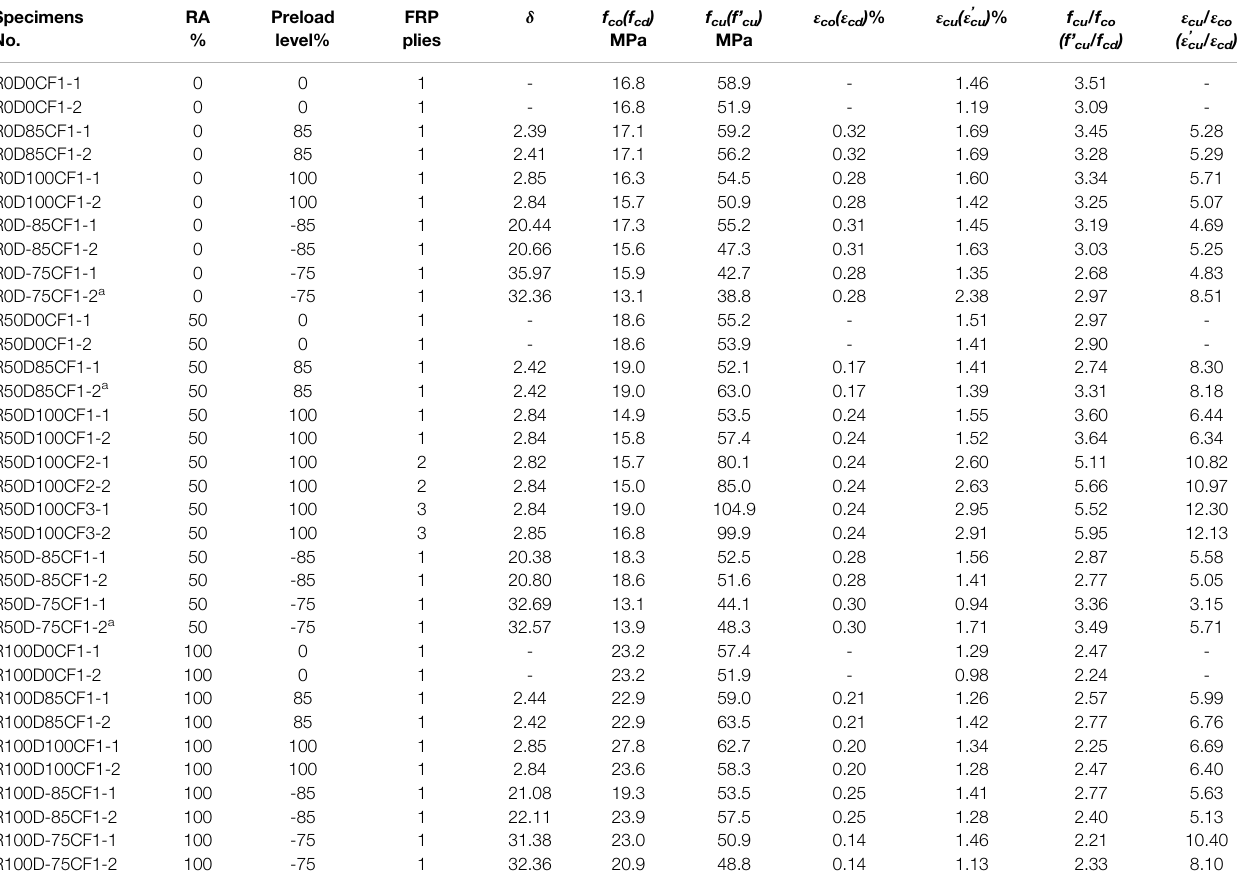
TABLE 7 | Test results for CFRP con fi ned specimens Specimens